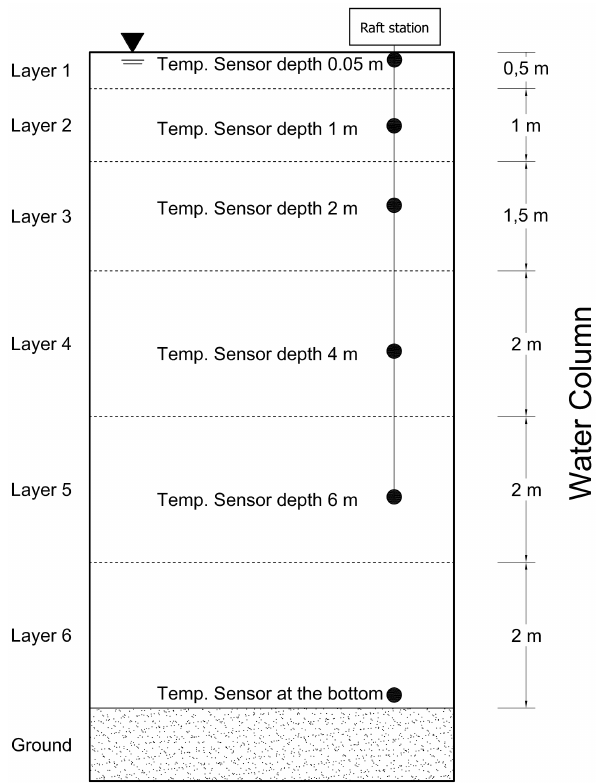
Figure A1. Layer thickness and temperature sensor locations (black circles). Sensors for layers 1, 2, 3, 4 and 5 are attached to the raft. The thickness of layer 6 varies with lake level and is taken into account in the calculation of the heat storage term (see Eq. 4).